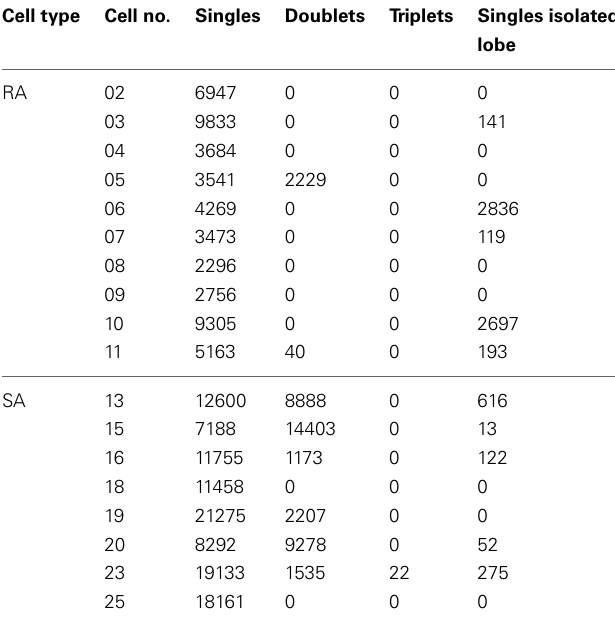
Table 1 | Numbers of spike patterns as identified with corrected autocorrelograms for each cell (cf. Figure